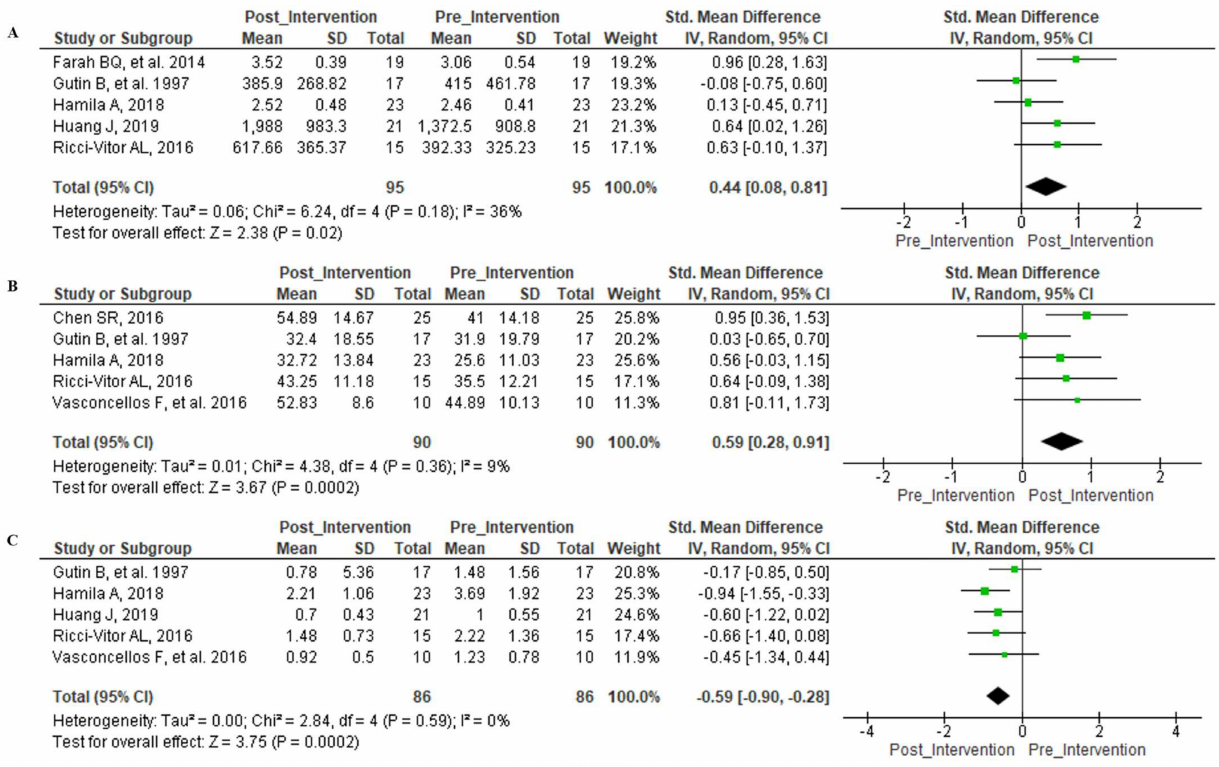
Figure 3. Forest Plot—Frequency Domain indices. Legend—( A ): HF ms 2 ; ( B ): HF n.u.; ( C ): LF/HF ratio. The non-linear metric SD1 was equated for both post-intervention and pre-intervention, with both indicating a significant effect (Z = 2.92 ( p = 0.004)) without significant hetero- geneity (Figure 4A). SD2 index had a negative effect (Z = 3.80 ( p = 0.0001)) for both post-intervention and pre-intervention without significant heterogeneity (Figure 4B).